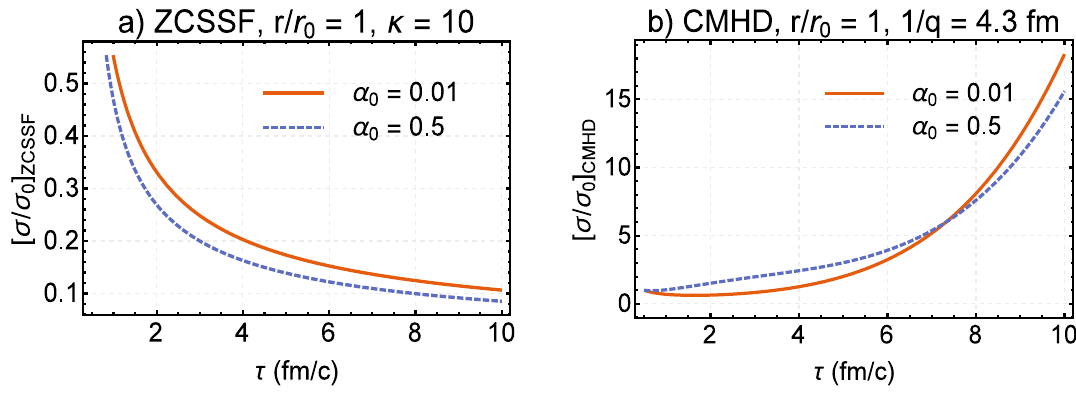
Figure 8 . (color online). The τ dependence of [ σ/σ 0 ] for the ZCSSF solution (panel a) and the CMHD solution (panel b) is plotted at r = r 0 and for α 0 = 0 . 01 (solid orange curves) and α 0 = 0 . 5 (dashed blue curves). For the CMHD solution q is chosen to be q = 1 / 4 . 3 fm − 1 . The parameter κ , appearing in the EOS ǫ = κp is chosen to be κ = 10 for the ZCSSF and κ = 3 for the CMHD solution. In contrast to [ σ/σ 0 ] ZCSSF , [ σ/σ 0 ] CMHD increases with increasing τ . Different choices for α 0 affect the evolution of σ/σ 0 .